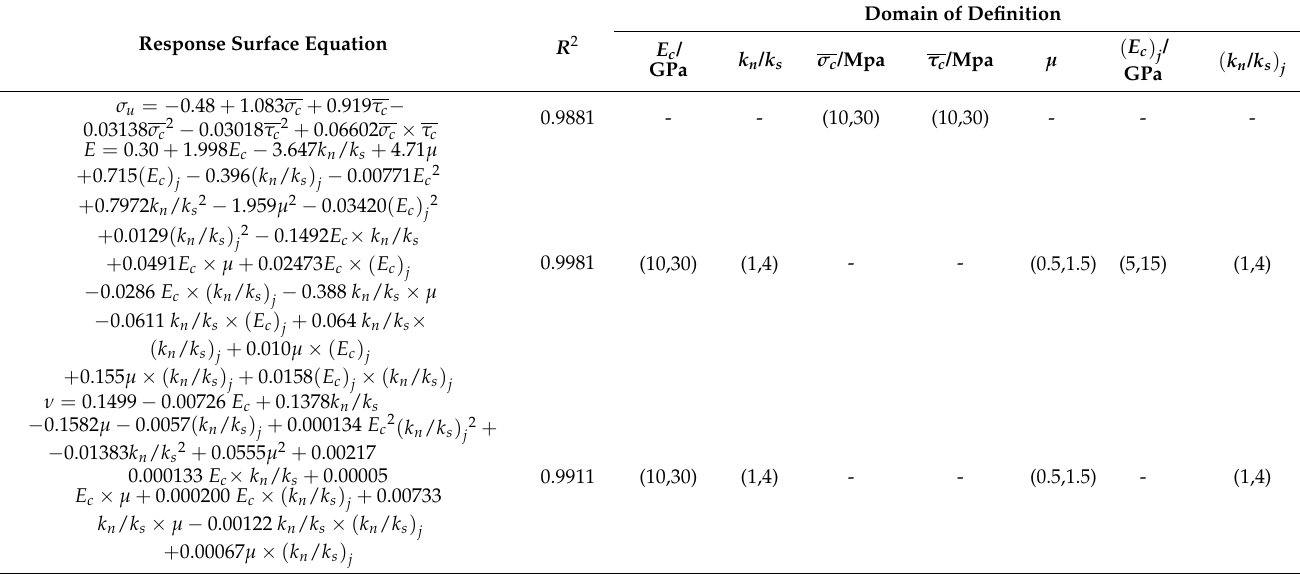
Table 12. Fitting Equation of σ u , E and ν